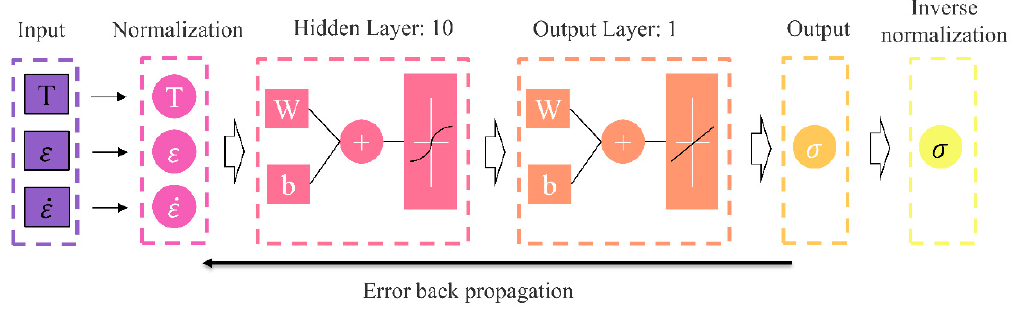
Figure 5. Schematic of the BP ANN with a single hidden layer.